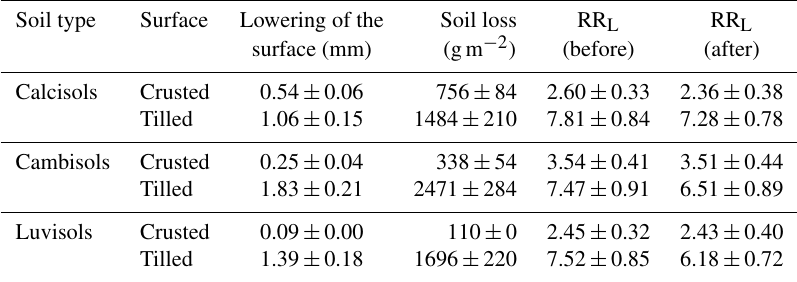
Table 2. Average lowering of the soil surface, soil loss and random roughness (RR L ) before and after wind experiments in different soil